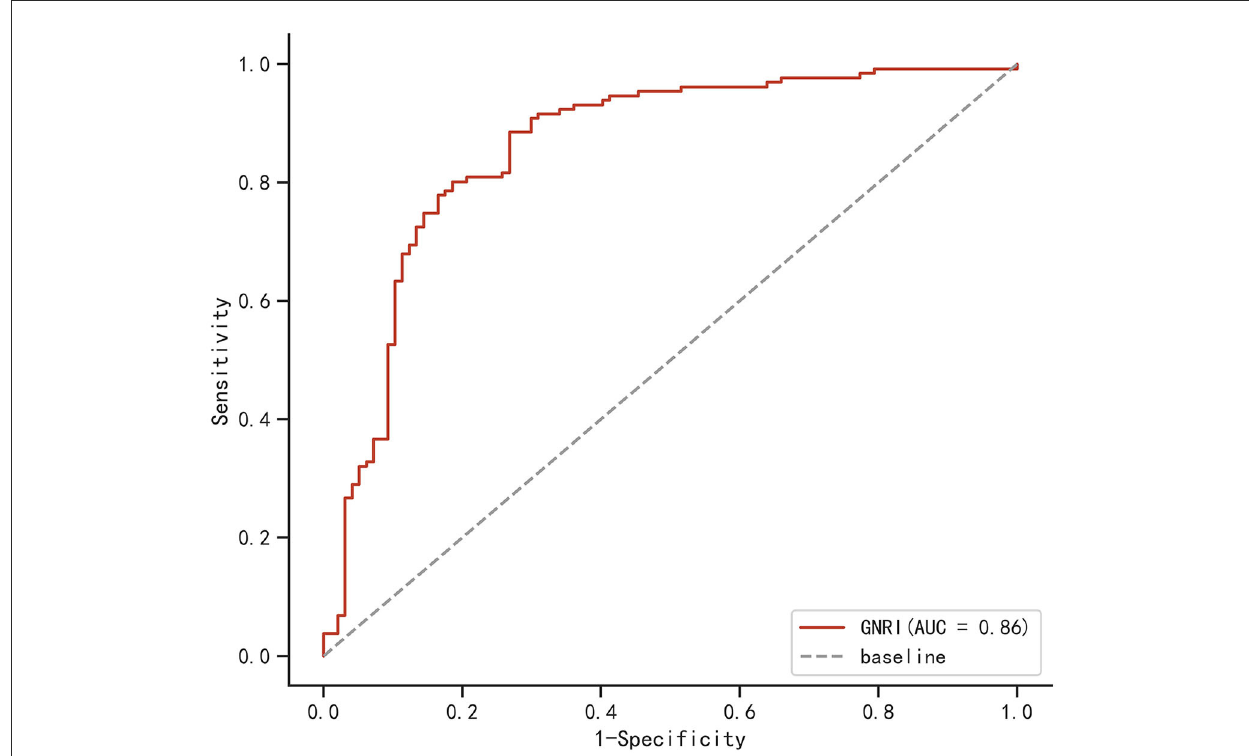
FIGURE2 Receiver operating characteristic curve (ROC) of the geriatric nutritional risk index (GNRI) for the prediction of poor recovery in elderly mild traumatic brain injury (mTBI) patients. The area under the curve (AUC) for the GNRI was 0.860 (95% CI: 0.806–0.911, p < 0.001; sensitivity: 88.5%, specificity: 73.2%; cutoff value: